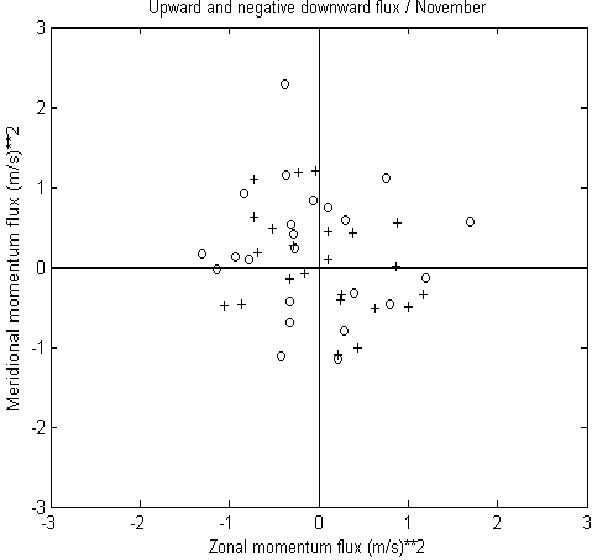
Fig. 8b. Same as Fig. 8a except for Fig.8b Same as Fig.8a except for the month of July.